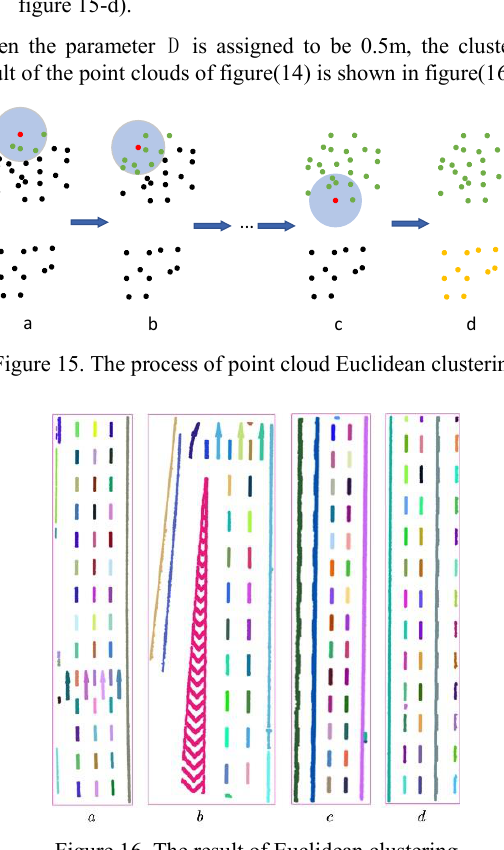
Figure 16. The result of Euclidean clustering